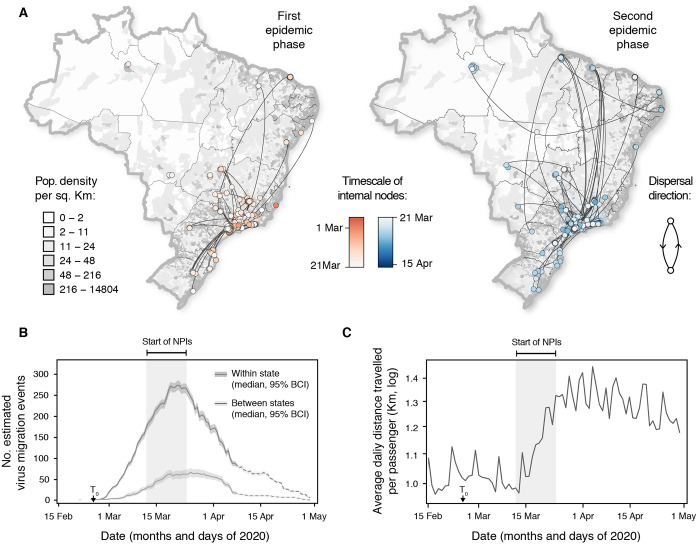
Spread of SARS-CoV-2 in Brazil.(A) Spatiotemporal reconstruction of the spread of Brazilian SARS-CoV-2 clusters containing >2 sequences during the first (left) and the second epidemic phase (right) epidemic phase (Fig. 3B). Circles represent nodes of the MCC phylogeny and are colored according to their inferred time of occurrence. Shaded areas represent the 80% highest posterior density (HPD) interval and depict the uncertainty of the phylogeographic estimates for each node. Solid curved lines denote the links between nodes and the directionality of movement. Sequences belonging to clusters with <3 sequences were also plotted on the map with no lines connecting them. Background population density for each municipality was obtained from the Brazilian Institute of Geography (https://www.ibge.gov.br/). See fig. S14 for details of virus spread in the Southeast region. (B) Estimated number of within state (or within a given federal unit) and between-state (or between federal units) virus migrations over time. Dashed lines indicate estimates obtained during period of limited sampling (fig. S2). (C) Average distance in kilometres travelled by an air passenger per day in Brazil. Number of daily air passengers is shown in Fig. 3B. Light grey boxes indicate starting dates of NPIs across Brazil.